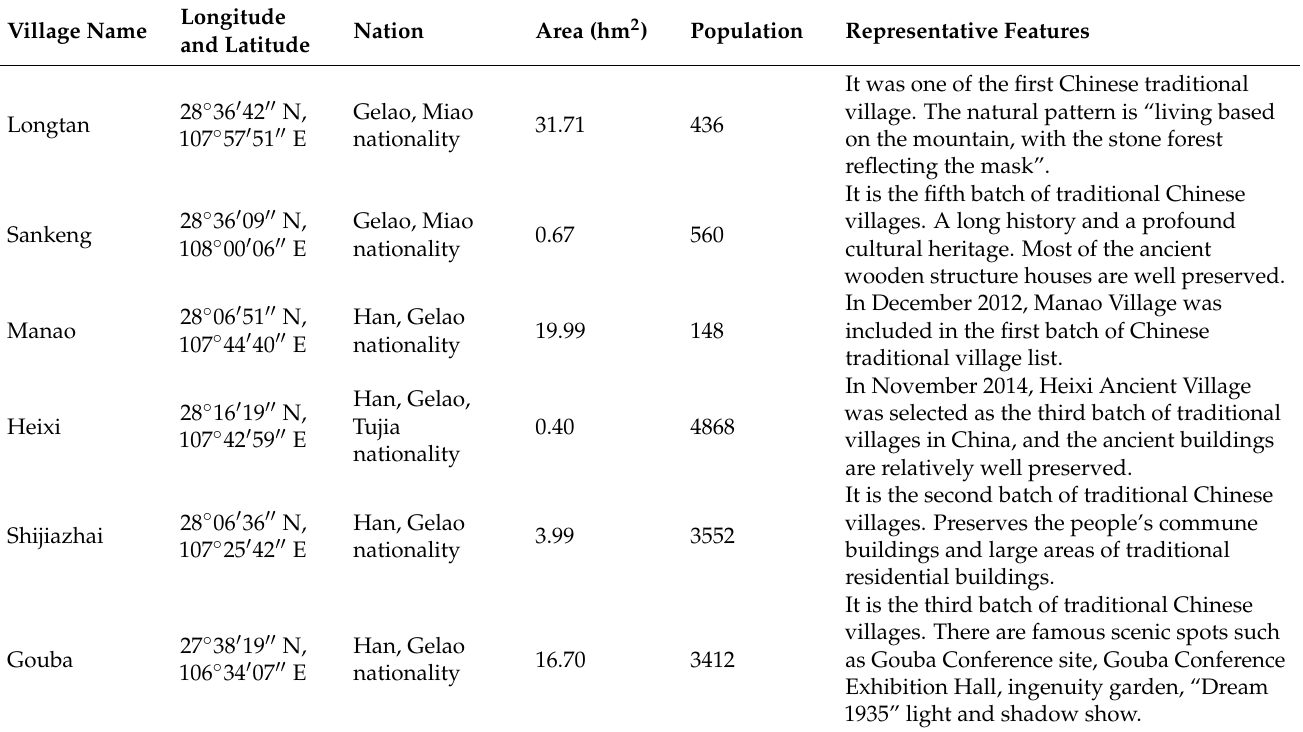
Table 1. Basic situation and representative characteristics of research villages.